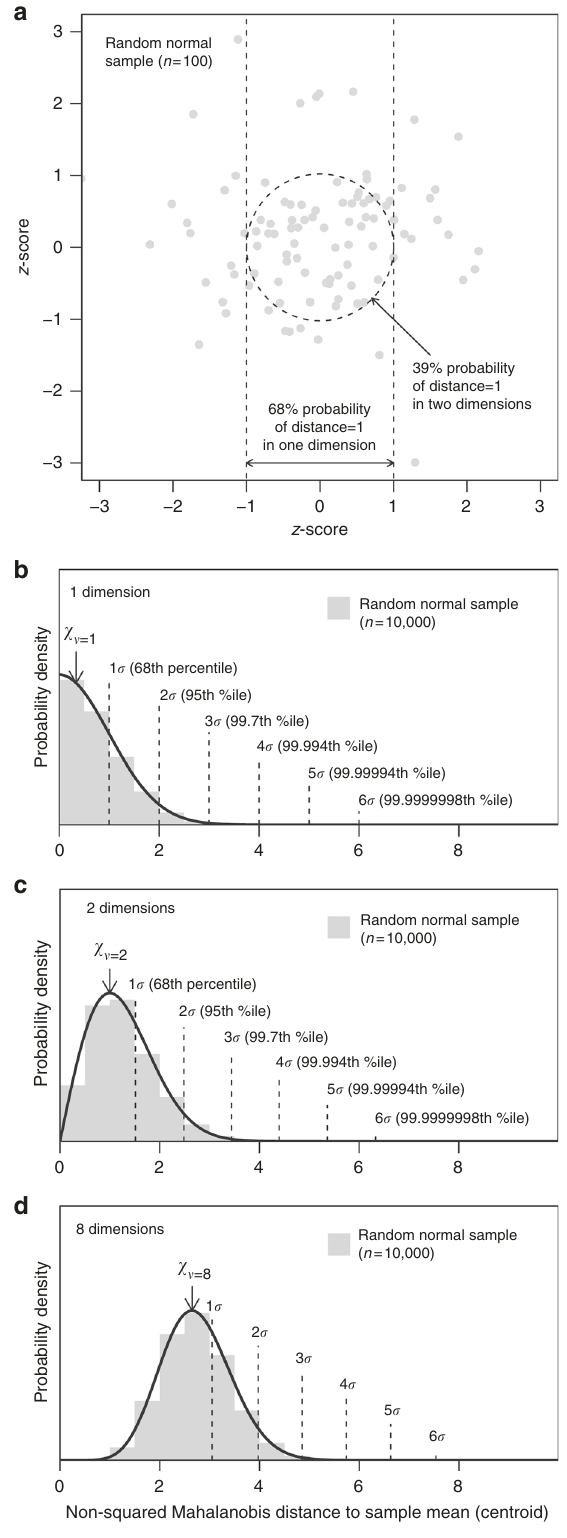
Fig. 6 Illustration of sigma dissimilarity for direct probabilistic comparison between anomalies of different dimensionality. a The effect of dimensionality on the probabilities of distances can be visualized using a sample from a standard bivariate normal distribution. In any one dimension, there is a 68% probability that an observation will be within one standard deviation ( z -score) of the mean. In two dimensions, the probability that an observation will fall within a distance of one from the centroid is reduced to 39%. b – d As dimensionality increases, the mean distance to observations increases, and even the observation closest to the mean becomes distant. This effect of dimensionality on the probability density of distances in multivariate normal data is described by the chi distribution ( χ ) with degrees of freedom ( ν ) equaling the dimensionality of the data 51 . The sigma dissimilarity metric is a re-expression of chi percentiles using the terminology of univariate z -scores; i.e., 1, 2, and 3 sigma ( σ ) for the 68th, 95th, and 99.7th normal percentiles, respectively. The chi distribution in one dimension is a half-normal distribution, and the sigma levels correspond to distance. This result is expected because Mahalanobis distances in one dimension are the absolute values of z -scores. At increasing dimensionality, the sigma levels shift away from the origin. For example, 2 σ (the 68th percentile) occurs at Mahalanobis distances of 2, 2.5, and 4.0 in one, two, and eight dimensions, respectively. By extending sigma levels into multiple dimensions, sigma dissimilarity serves as